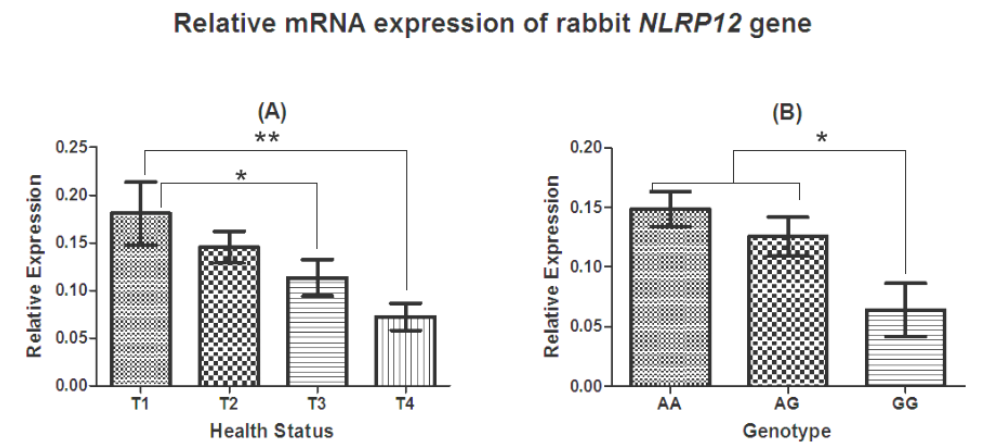
Figure 2. Relative mRNA expression of rabbit NLRP12 gene among T1-T4 groups (A) and three genotypes (B). Values are presented as mean  standard error of the mean (SEM). * Represents significant different (p<0.05), ** great significant